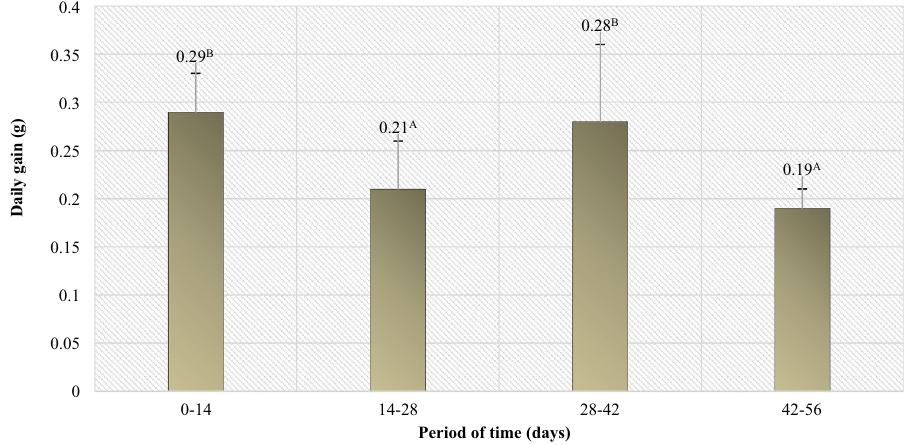
Figure 2. Average daily gain of lambs between the control weighing periods (kg). p < 0.05—A, B, C; p < 0.01—a, b,